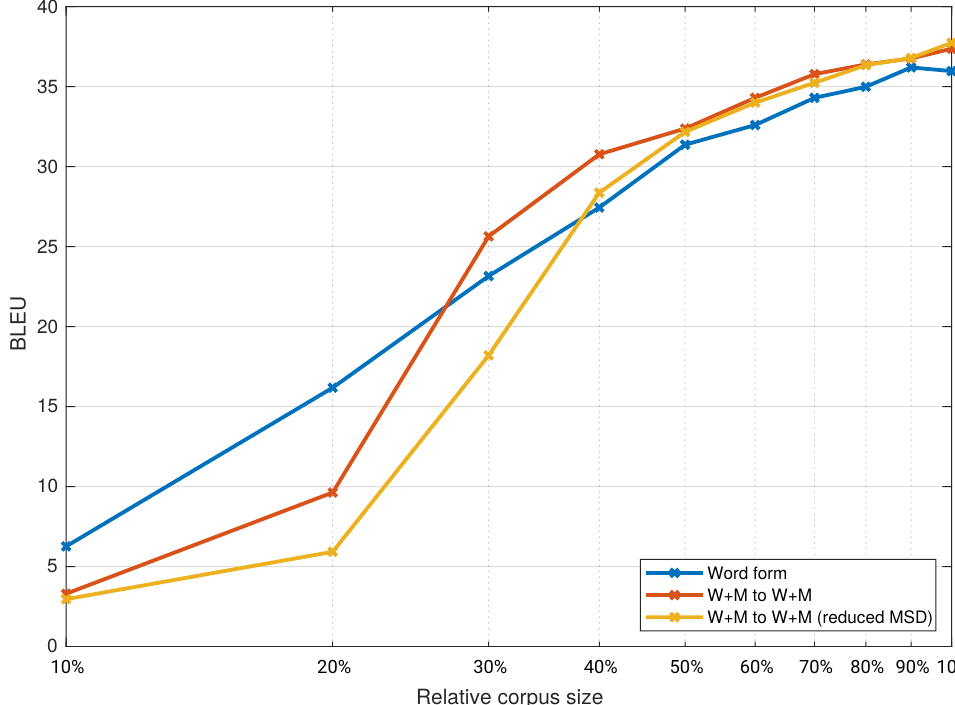
Figure 1. Translation results for the selected translation systems from English to Slovene using Europarl with respect to relative training corpora size.